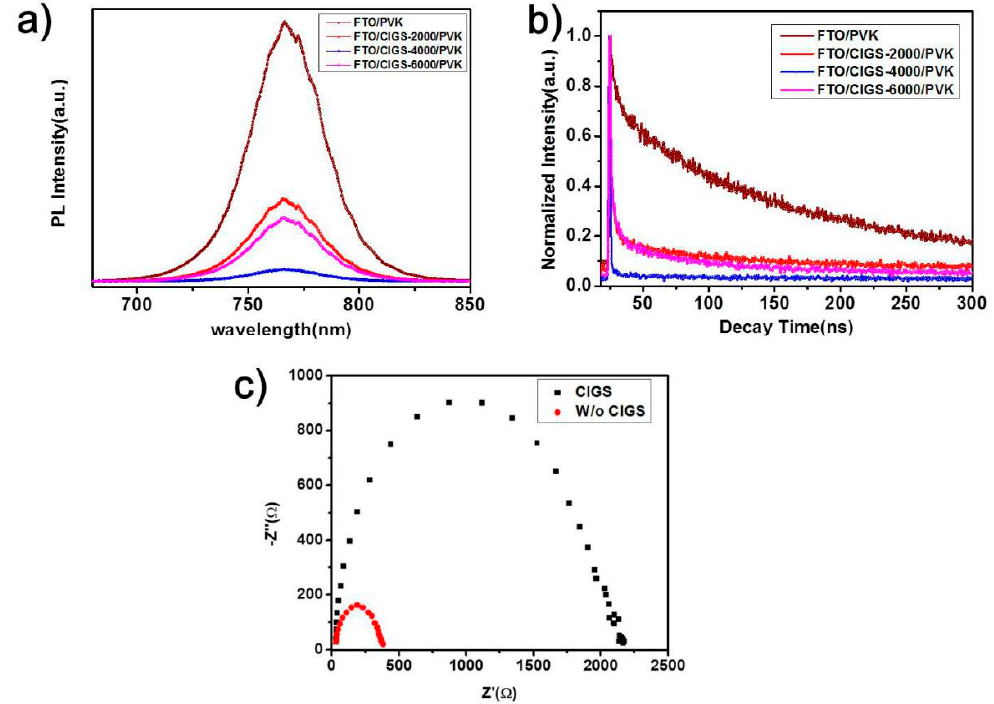
Figure 7. ( a ) Steady-state PL spectra and ( b ) time-resolved PL decays of perovskite films on the pristine FTO and the CIGS films at different spin speeds. ( c ) Nyquist plots for the PSCs with and without CIGS thin film as HTL.